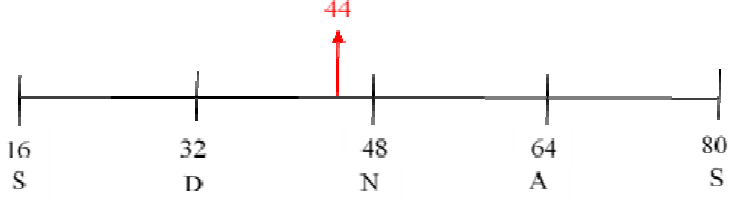
Figure 2: The score of likert-scale questionnaire answered by the high-proficiency